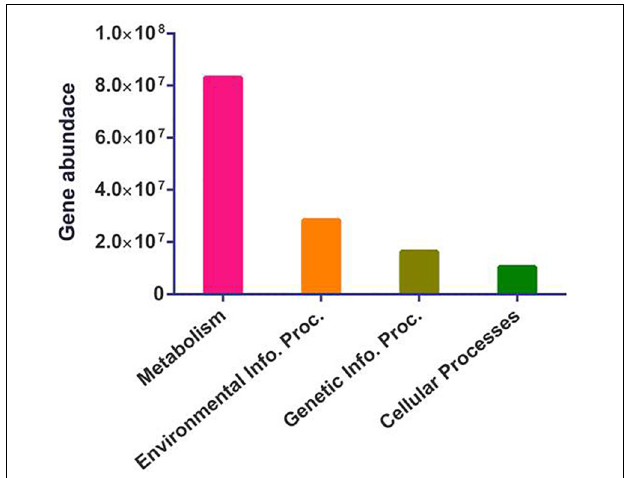
FIGURE 6 | Functional imputations. It represents the differential abundance of metabolism, environmental information processing (Environmental Info. Proc.), genetic information processing (Genetic Info. Proc.), and cellular processes-related gene families in the gut bacterial communities of A. florea